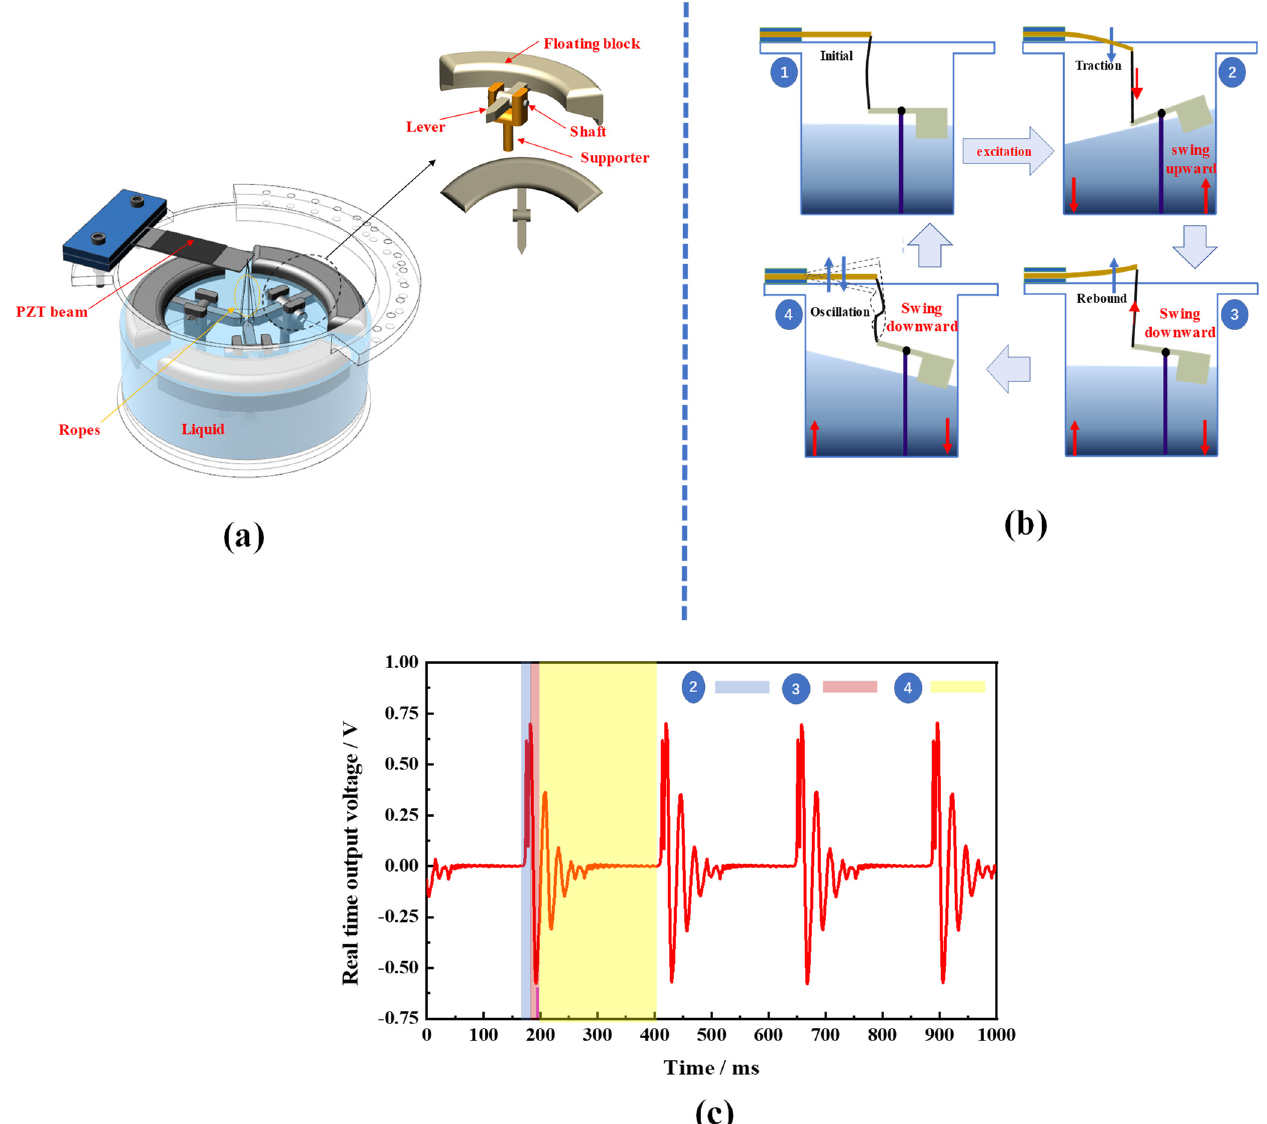
Figure 1. ( a ) Components of the PVEH; ( b ) operating principle of the PVEH; ( c ) real − time output voltage of the PVEH.